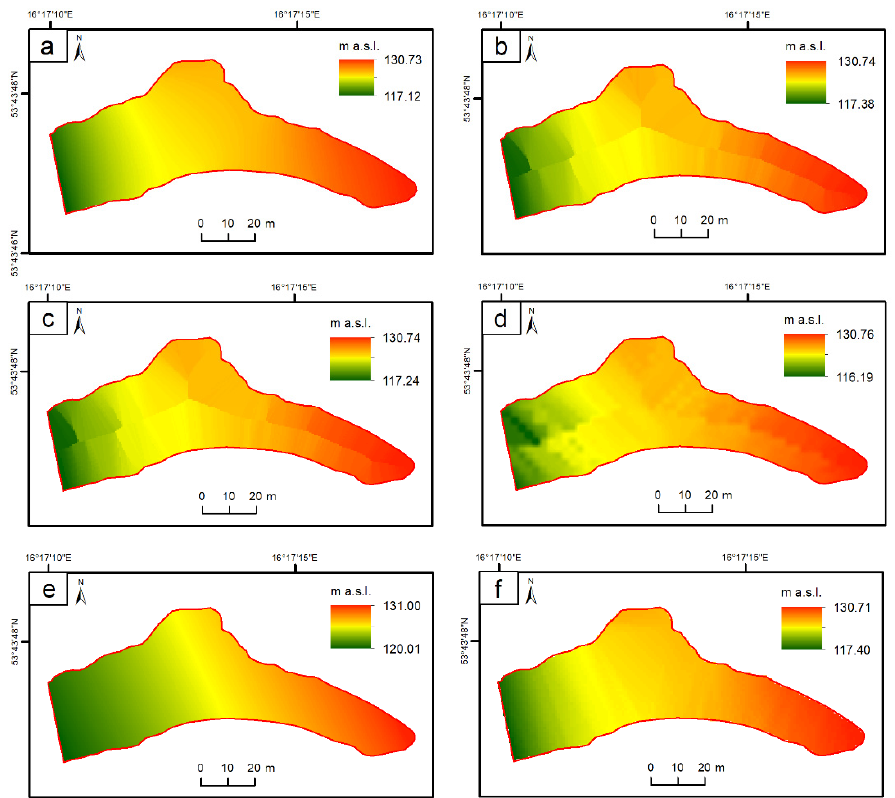
Figure 7. Comparison of various methods for the interpolation of the overlay surface: ( a ) Natural Neighbor method; ( b ) IDW method; ( c ) Kriging method; ( d ) Spline method; ( e ) Trend method; ( f ) TIN method.